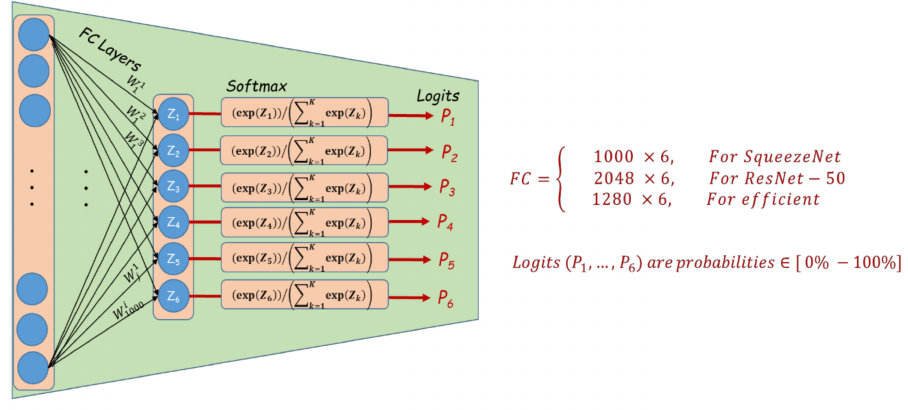
Figure 8. Development of output layers in the learning model